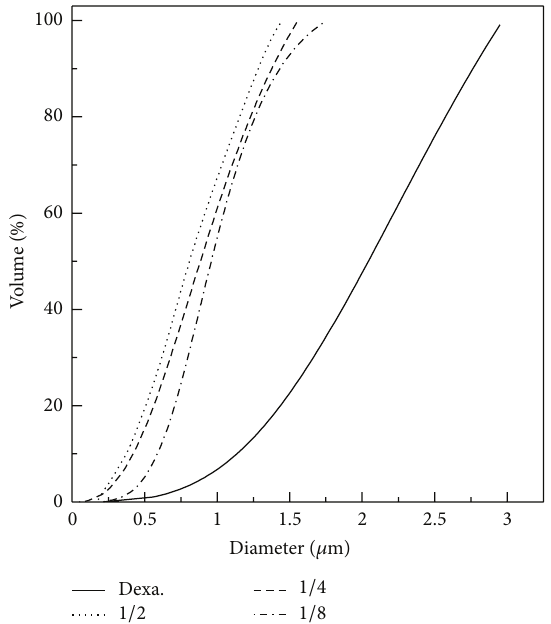
Figure 5: Volumetric cumulative particle size distribution of dex- amethasone-PVP composite particles produced by SAA at different drug/polymer weight ratios.